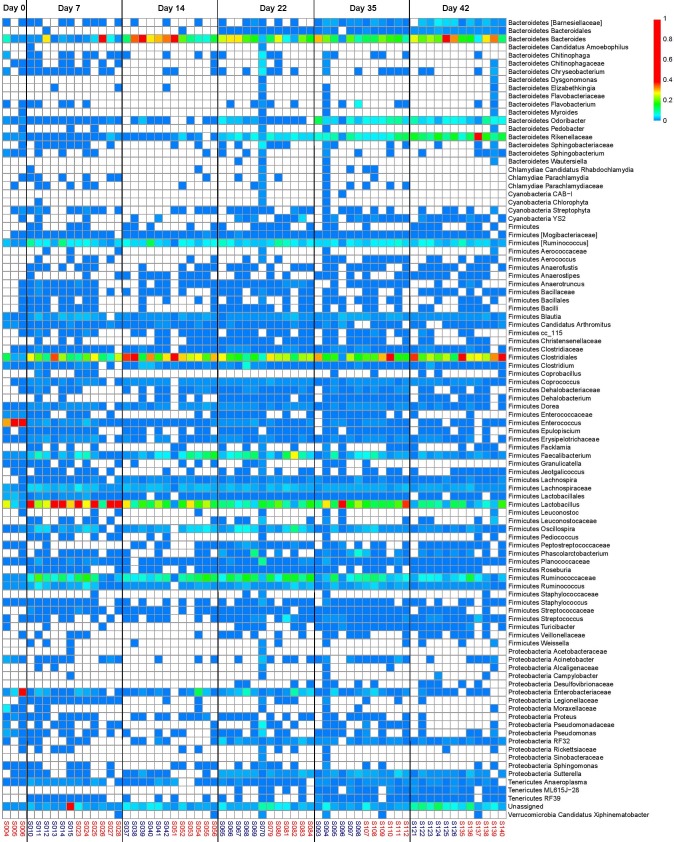
Heatmap of taxonomic groups present in the cecum of birds fed on BMD-diet and BMD-free diet (control group) across all ages (d0, 7, 14, 22, 35 and 42).The sample numbers (n = 6 for each time point) in red are of control diet and blue are of BMD diet.